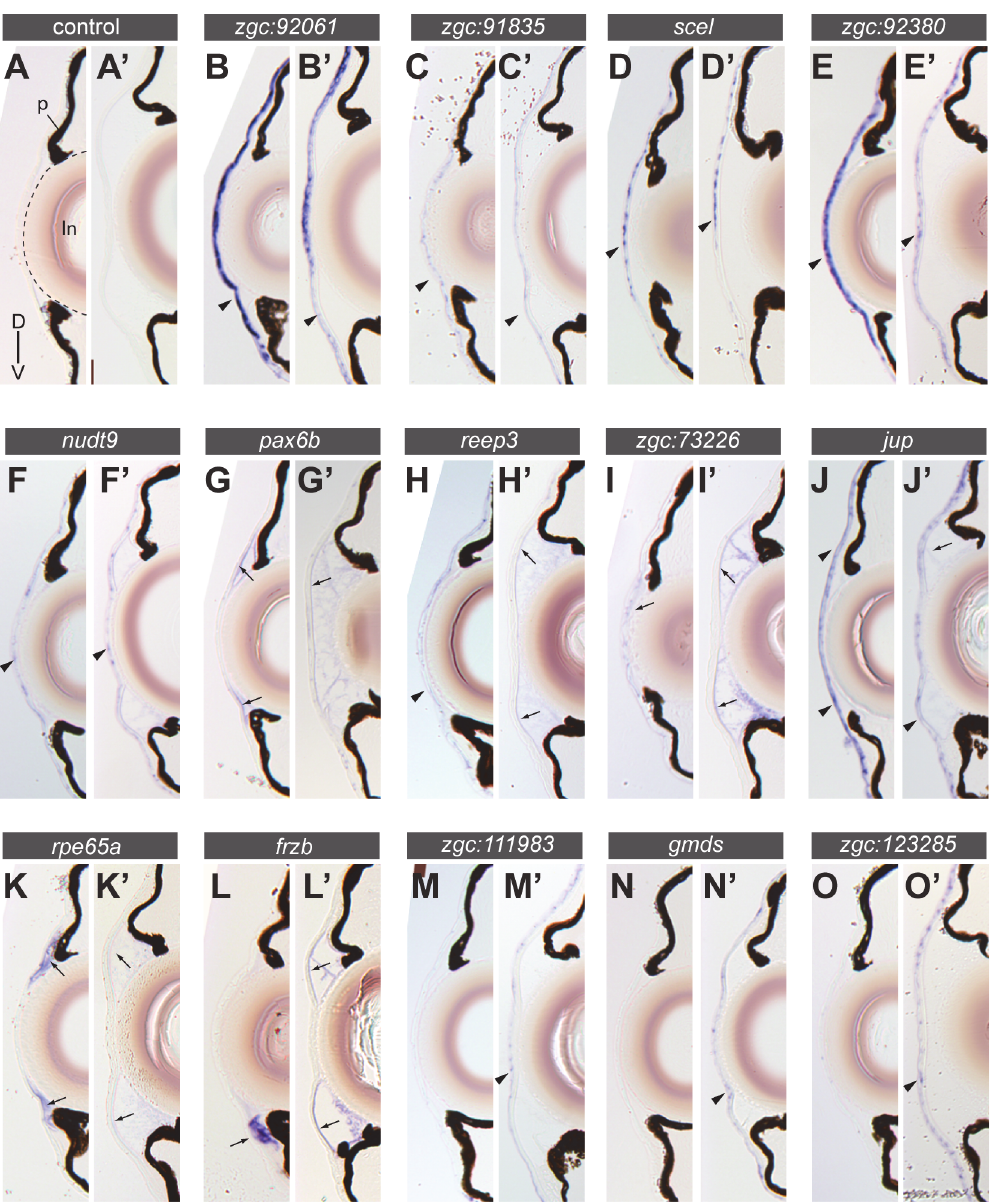
Fig 4. Comparison of gene expression in the cornea of wild type zebrafish at 7 dpf (A-O) and 1-month stage (A ’ -O ’ ). Transverse sections with dorsal up. (A) Negative controls without probe showed no staining at both stages, except for background staining in the lens (ln, outlined by a stippled line). p: pigmentation in the iris and the retinal pigment epithelium. (B-K ’ ) Examples of genes expressed at both 7 dpf and 1-month stage are shown. A subset of genes (B-F ’ ) is mainly expressed in the corneal epithelium (arrowheads) and another subset (G-K ’ ) shows expression in the corneal endothelium (arrows). (L-O ’ ) Examples of genes that are mainly expressed at the 1-month stage. A subset of genes (M-O ’ ) is expressed in the corneal epithelium (arrowheads) and another subset (L-L ’ ) in the corneal endothelium (arrows). The gene symbols are indicated in the bar above each pair of sections. Scale bar: (A-O) 80 μ m; (A ’ - O ’ ) 100 μ